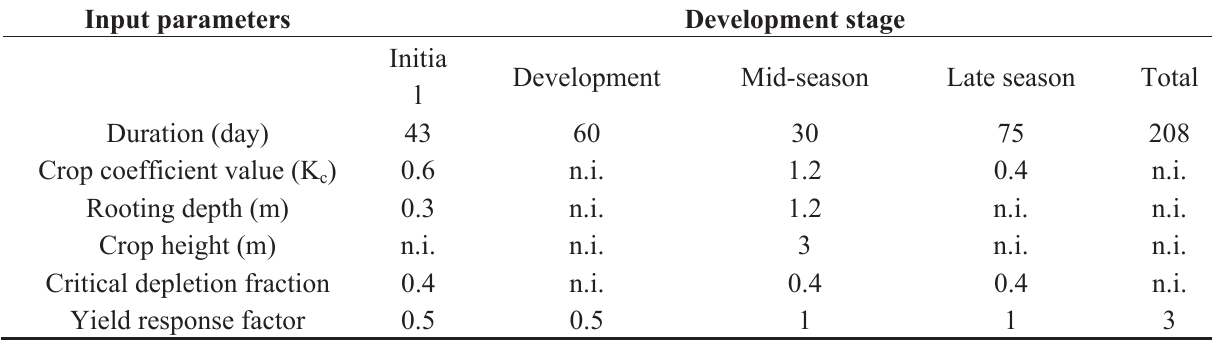
Table 2. Input parameters for calculating crop evapotranspiration of a potential jatropha plantation in the reference climate of Tan-Tan Morocco with CROPWAT